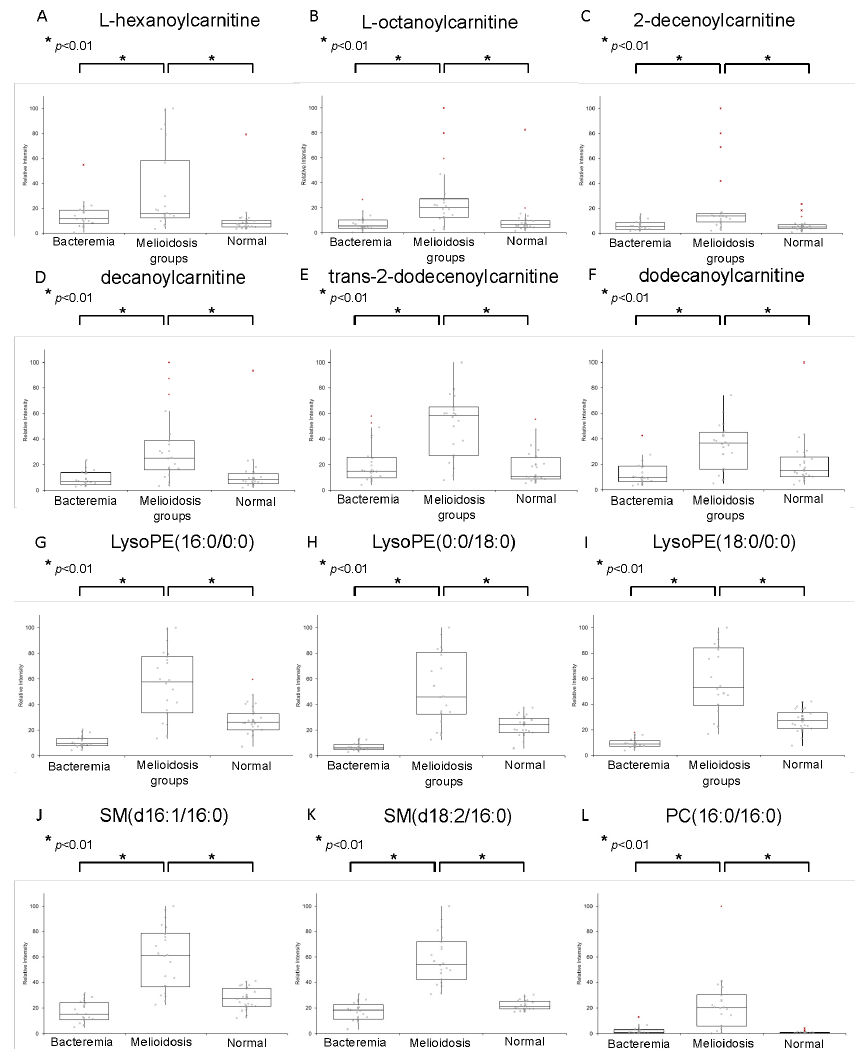
Figure 4. Box-and-whiskers plots representing relative abundance of: ( A ) L -hexanoylcarnitine; ( B ) L -octanoylcarnitine; ( C ) 2-decenoylcarnitine; ( D ) decanoylcarnitine; ( E ) trans -2-dodecenoylcarnitine; ( F ) dodecanoylcarnitine; ( G ) LysoPE(16:0/0:0); ( H ) LysoPE(0:0/18:0); ( I ) LysoPE(18:0/0:0); ( J )